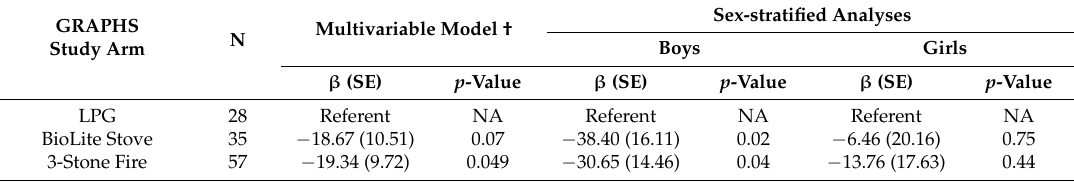
Table A1. Association between GRAPHS study arm and cord blood mononuclear cell mitochondrial DNA copy number (mtDNAcn) *: Linear